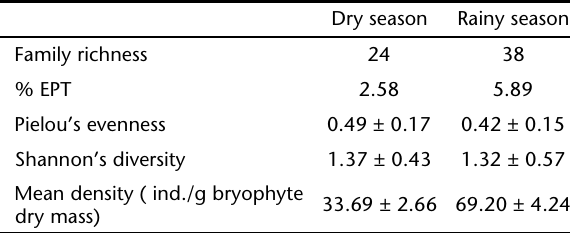
Table III. Family richness, %Ephemeroptera+Plecoptera+ Trichoptera (EPT), mean values for Shannon’s diversity, Pielou’s evenness, and density of individuals associated to stream bryophytes in the Poço D’Anta Municipal Biological Reserve, during the dry and the rainy